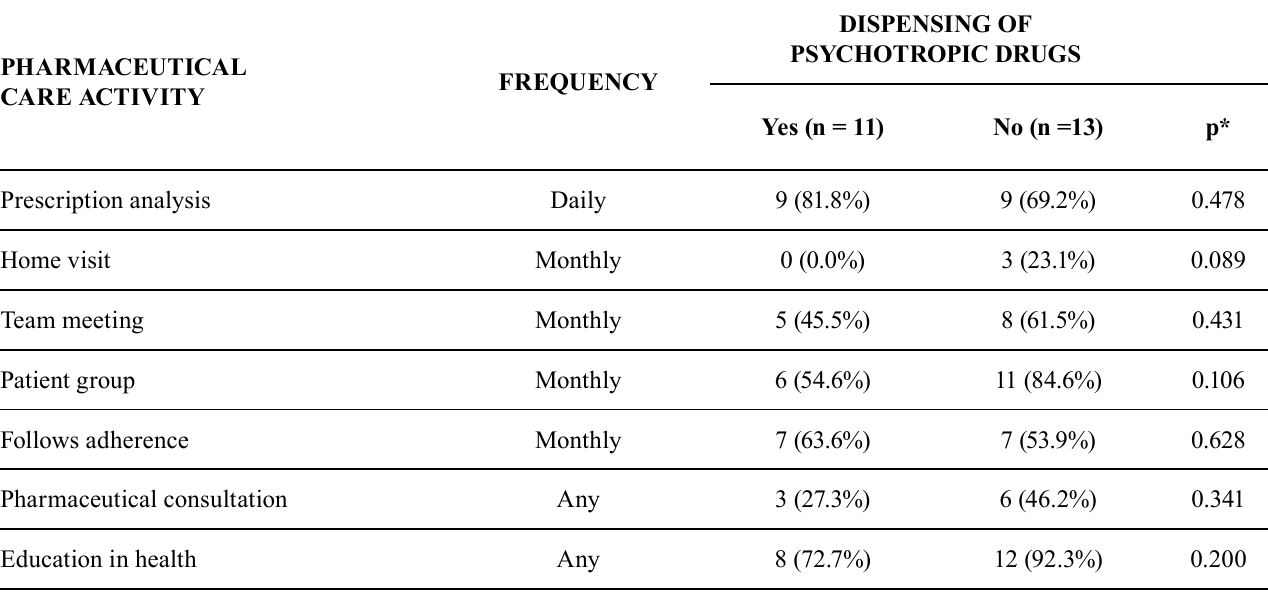
TABLE V – A ssociation of dispensing of psychotropic drugs with the frequency of Pharmaceutical Care activities in the primary health center (UBS) of São Bernardo do Campo, 2018